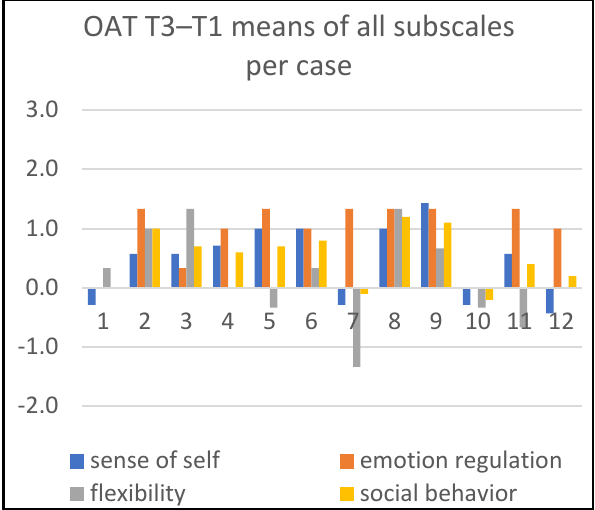
Figure 2. Means of all subscales per case, T2–T1.